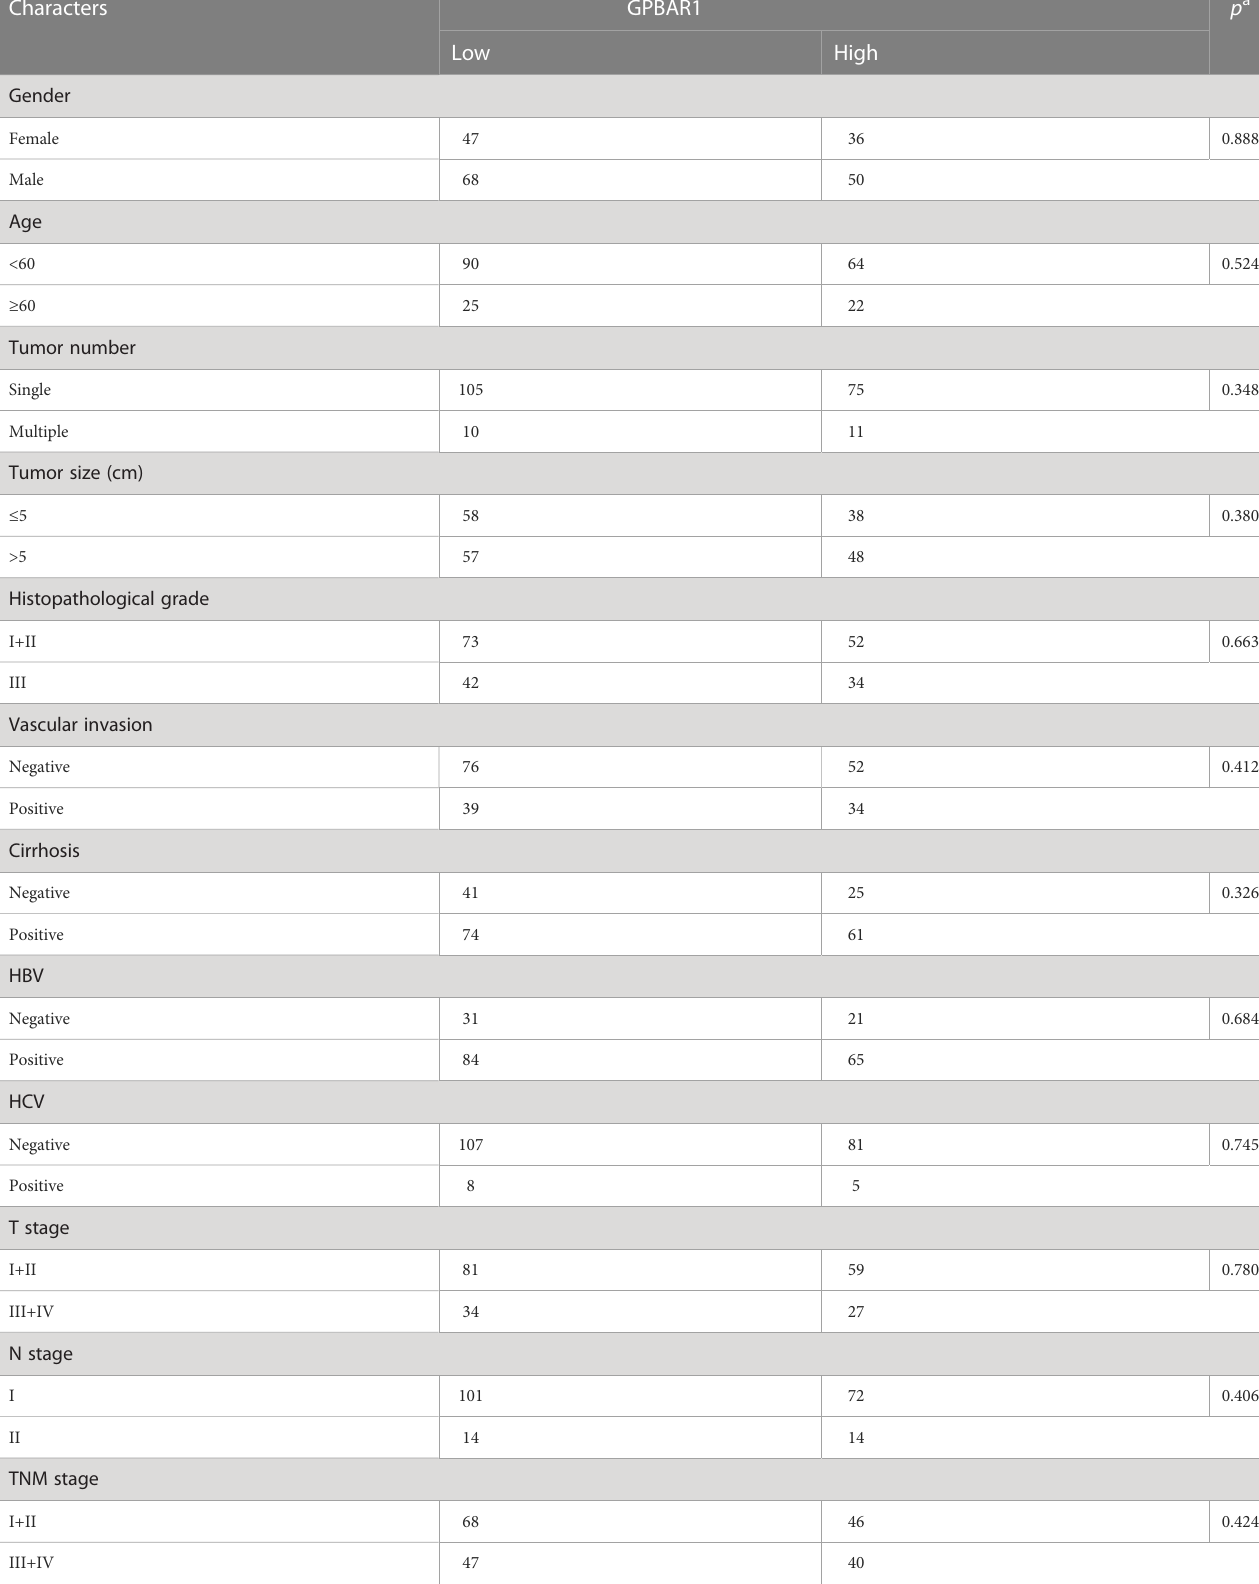
TABLE 1 Correlation between GPBAR1 and clinicopathological